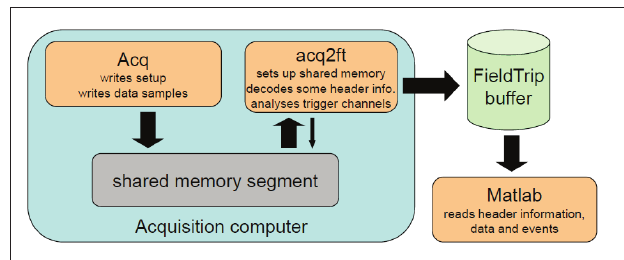
Figure 6 | A schematic illustration of how real-time data access can be implemented. This example depicts the approached developed within the FieldTrip package working in conjunction with an MEG system. The MEG system acquisition software (Acq) writes data to a limited capacity memory segment set up on the acquisition computer (shared memory segment), which is the manufacturer-specific online interface. An external, manufacturer- independent buffer (FieldTrip buffer) is set up on the same or a different computer. An agent (acq2ft) continually monitors the shared memory segment for new data and copies them to the external buffer as soon as these become available. Once the data is in the external buffer they can be accessed and analyzed in Matlab for the purposes of the BCI. Crucially, the rapid copying of new data as soon as they become available to an external buffer deems